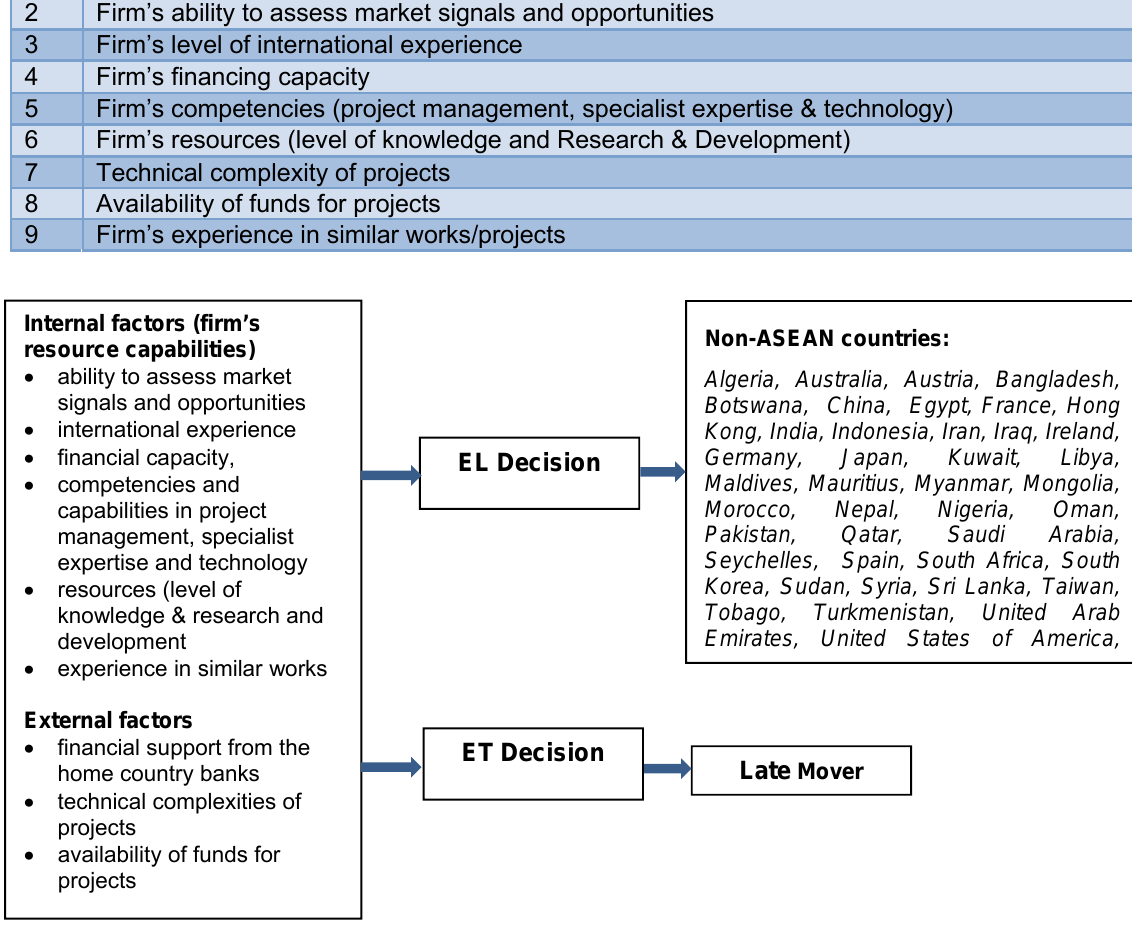
Figure 2: ELET decision model for Malaysian construction firms in international market (Developed from this